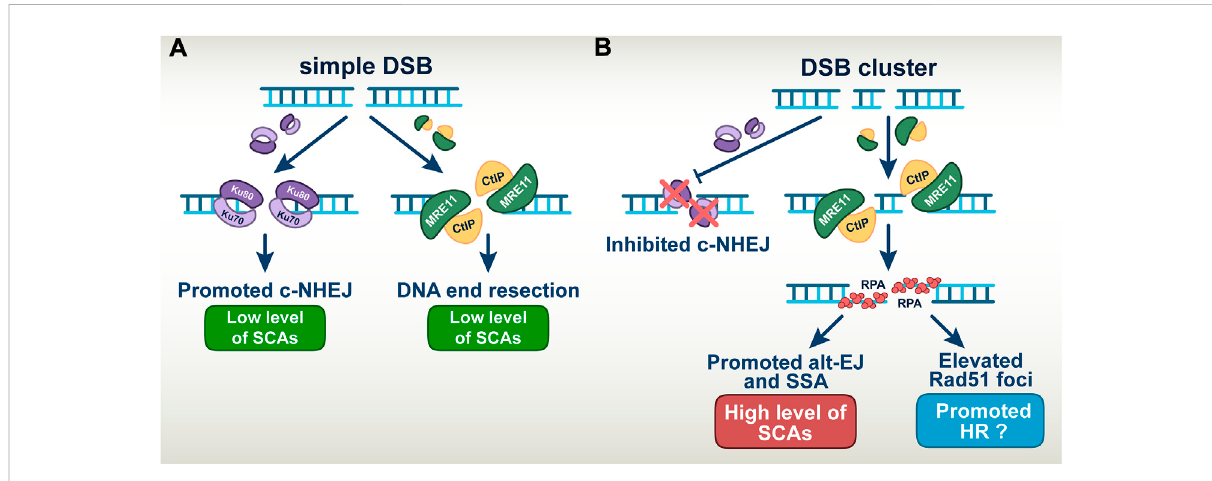
FIGURE 7 A model describing the altered DSB repair pathway balance in simple versus complex DSBs (A) Simple DSBs engage repair by both c-NHEJ and DNAend-resectiondependentpathways,whichresultsinlowlevelofSCAsformation. (B) DSBsclusterssuppresstherepairbyc-NHEJthusallowing the involvement of error-prone DNA end-resection dependent repair pathways. This manifests in the increased level of SCAs when alt-EJ and SSA areinvolvedinrepair.ElevatednumberofRAD51fociindicatestheinvolvementofHRintherepairofDSB-clusters;However,itremainsunclear to what extent HR is